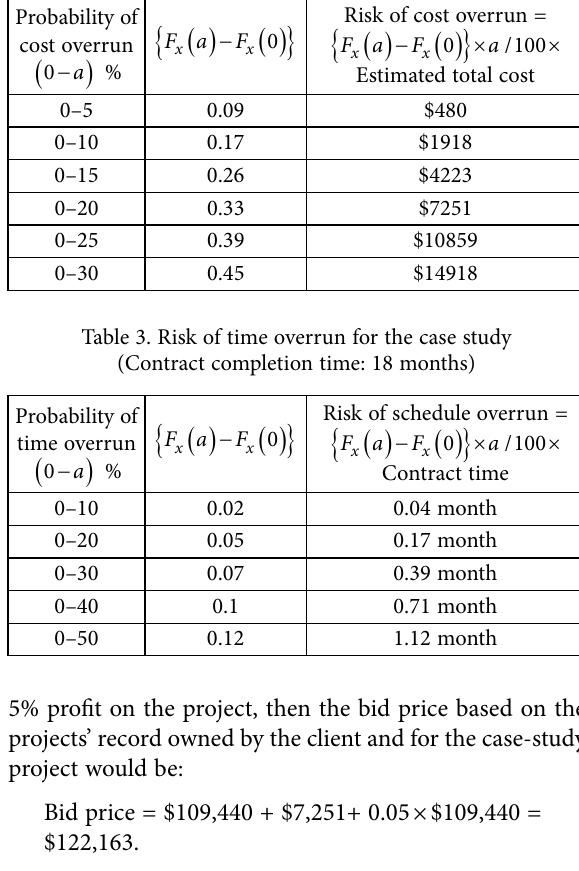
Table 2. Risk of cost overrun for the case study